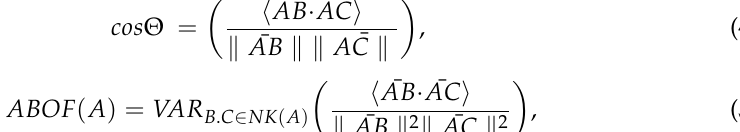
Figure 5. Conceptual model showing the application of OCSVM for outlier detection.